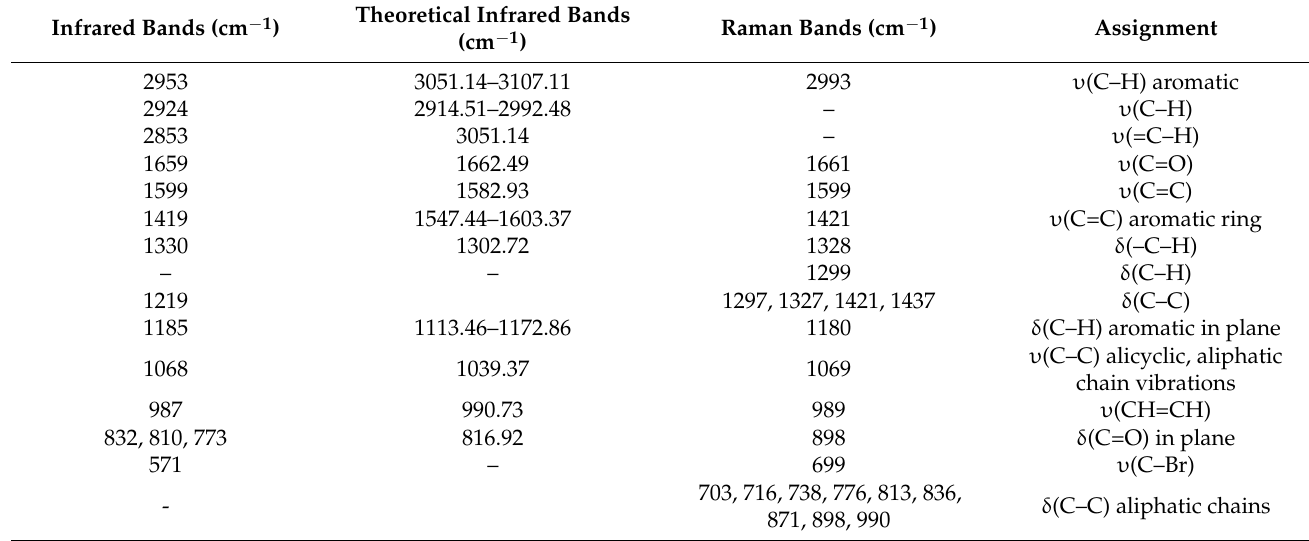
Table 1. Assignments of FT-IR; theoretical FT-IR and FT-Raman spectral bands for BBP.